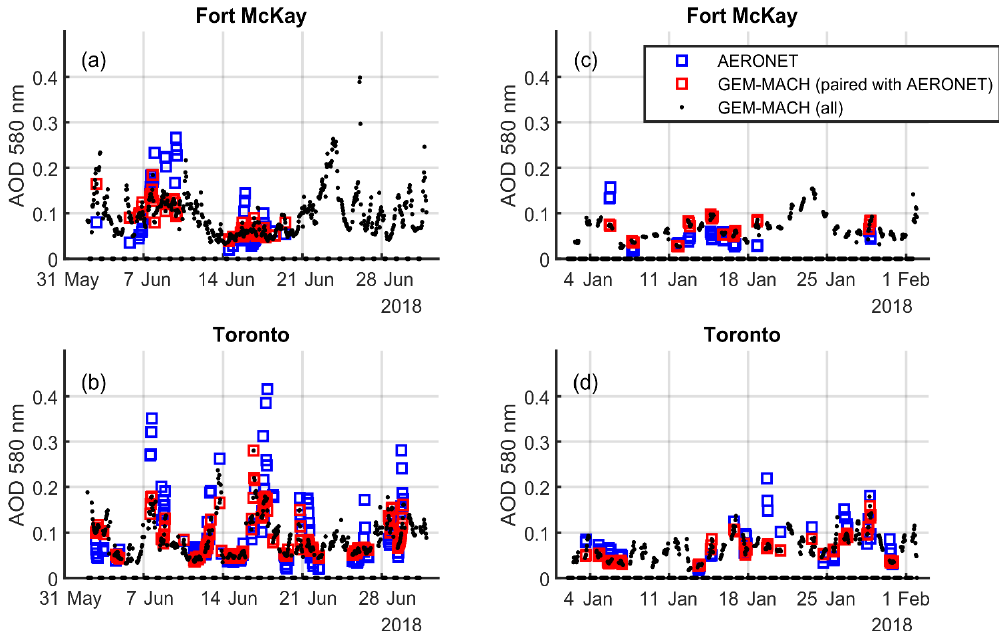
Figure 6. Time series of hourly AERONET and GEM-MACH AOD at 580nm at the Fort McKay (57.18 ◦ N, − 111 . 64 ◦ W) and Toronto (43.79 ◦ N, − 79 . 47 ◦ W) AERONET stations. (a, b) June 2018, (c, d) January 2018. The zero simulated values of AOD (black dots on the x axis) represent no calculation of molecular dissociation by sunlight in the model during nighttime